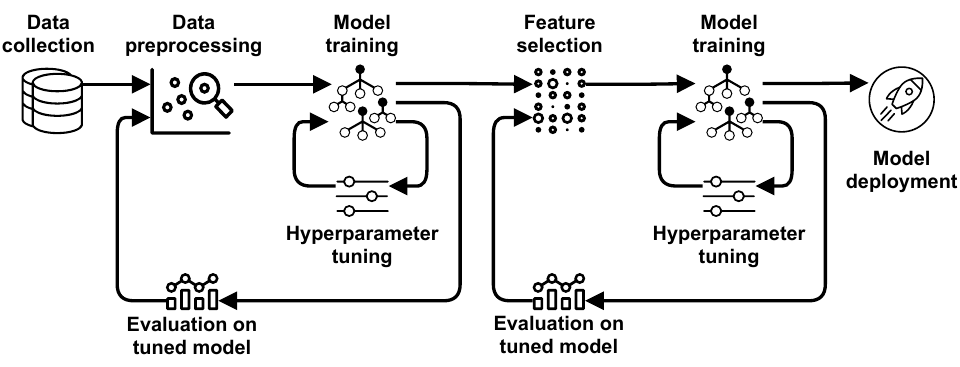
Figure 12. A fully-cycled data-centric